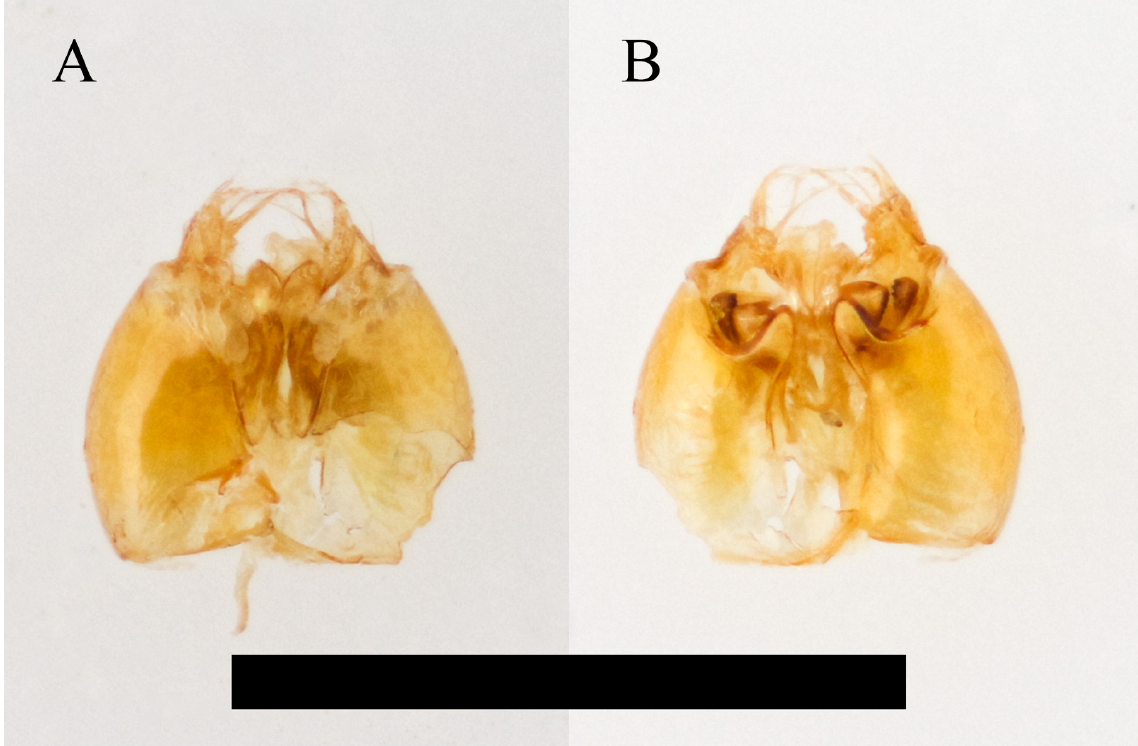
Fig. 19. Genital capsule of Habralictus antillarus sp. nov. Paratype, ♂. A . Dorsal view. B . Ventral view. Scale bar = 1